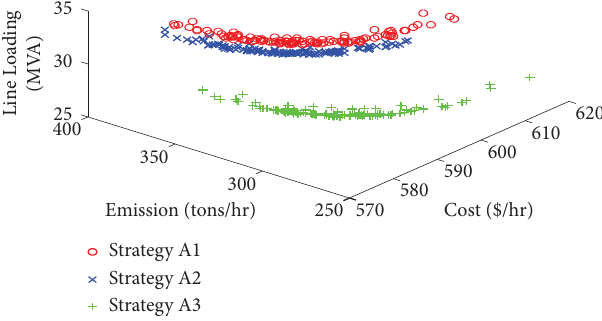
Figure 5: Comparison of pareto-optimal fronts for all strategies of group Table 7: Optimized power fow for case 1 strategy A